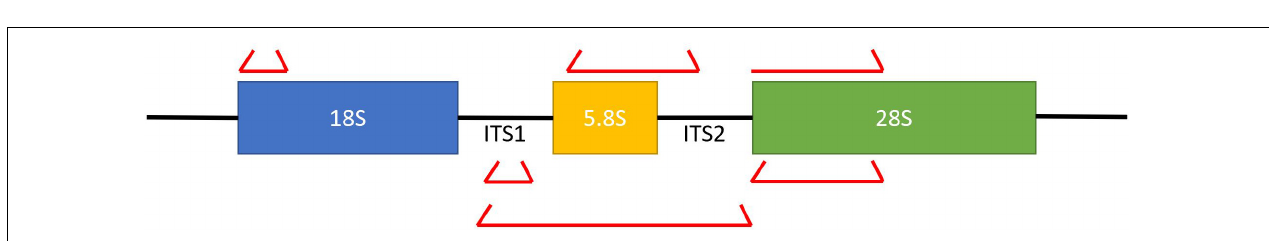
FIGURE 1 | Mycobiome affects a wide spectrum of diseases across various niches in the human body. The cooperative evolution of fungi and bacteria is a complex interplay, where it may be mutualistic in some conditions, while antagonistic in others.